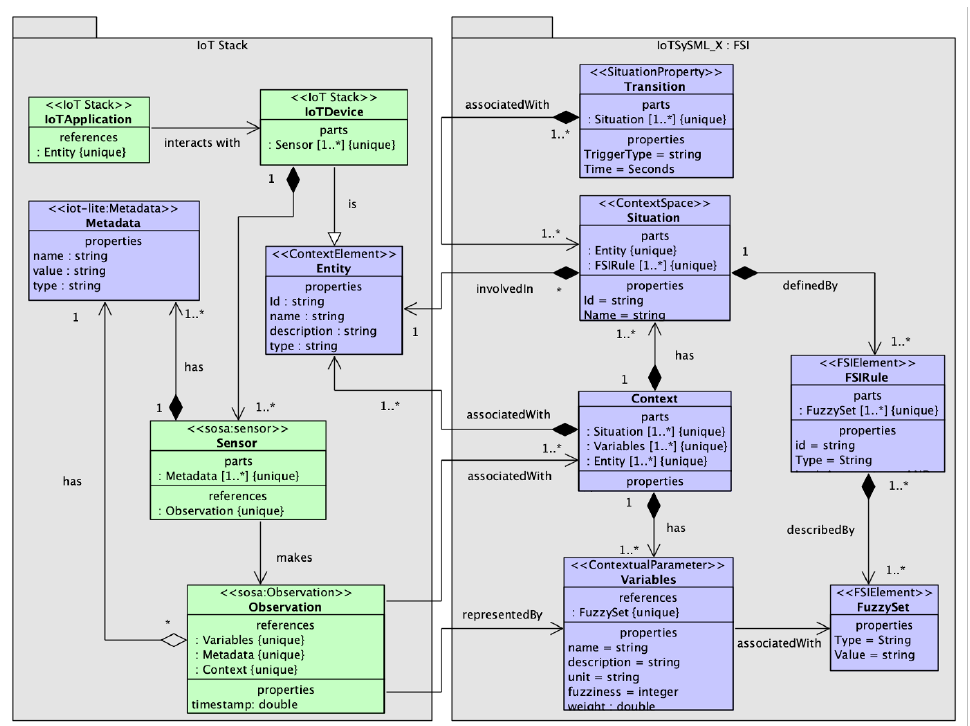
Figure 4. UML class diagram of the domain